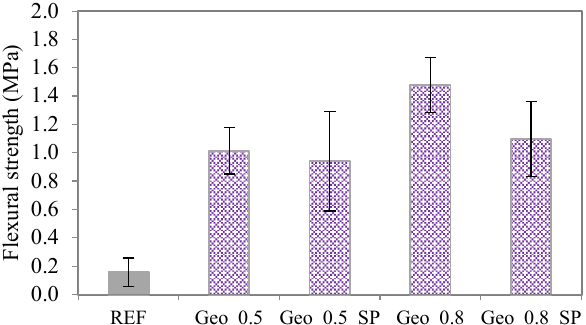
Figure 7. Flexural strength of grouts studied.